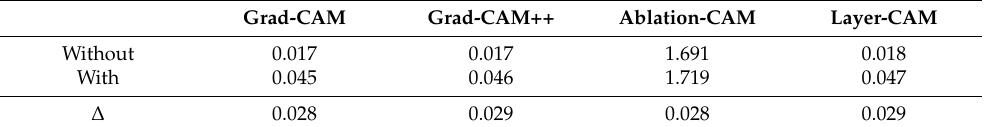
Table 5. Average runtime (in seconds) of generating an attribution map with and without our uncovering procedure using VGG-16. The ∆ indicates the difference between the two cases.